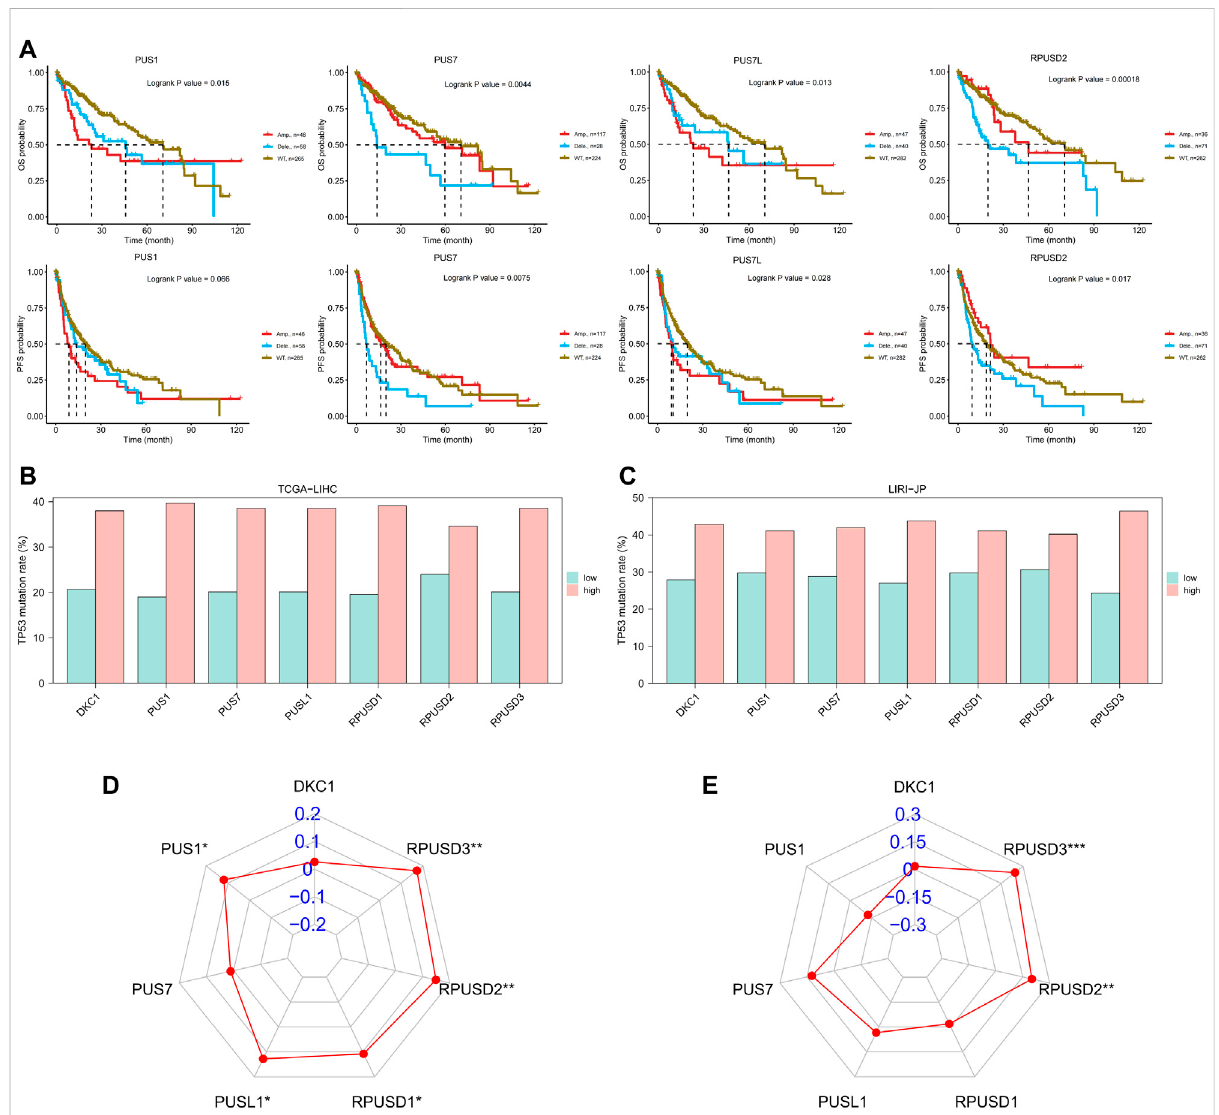
FIGURE 5 CNVs of PUSs and the correlation between PUSs and mutations. (A) Survival differences of HCC patients strati fi ed by PUSs CNV; (B – C) Differences in TP53 mutation rates in HCC tissues with low versus high PUS expression; (D – E) Correlation of PUSs expression with TMB. (** p < 0.01 and *** p <